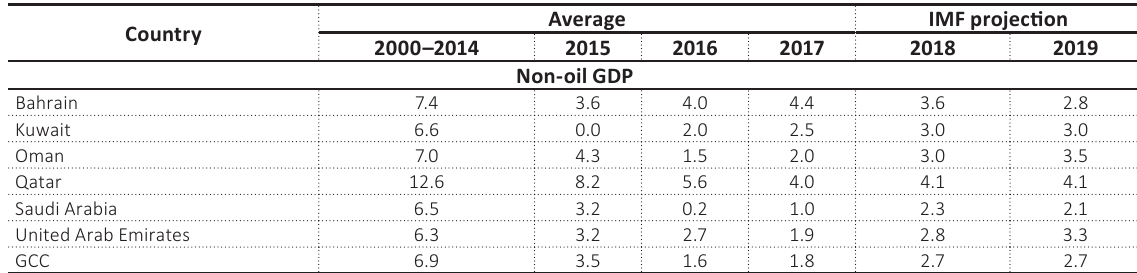
Table 3. Oil exports: growth in crude and non-crude GDP (%) Source: International Monetary Fund dataset (average 2000–2014 to